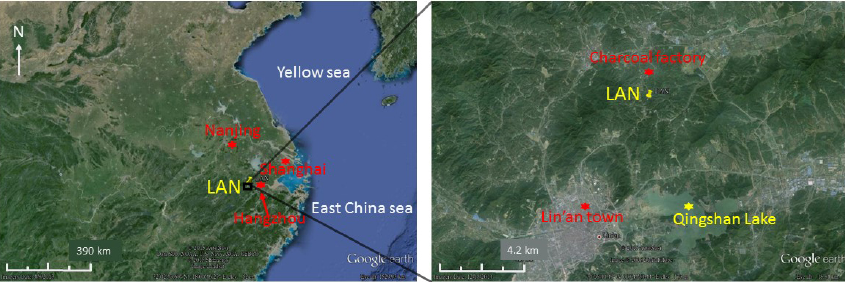
Figure 1. Geographic map of the LAN station. The red stars denote cities or towns near the station. The yellow star indicates the Qingshan Lake